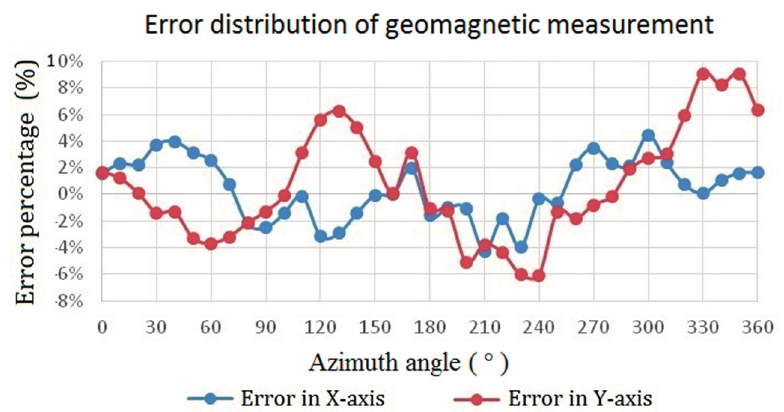
Figure 15. The geomagnetic measurement results of the planar fluxgate magnetometer as an electric compass under a excitation frequency of 25 kHz.